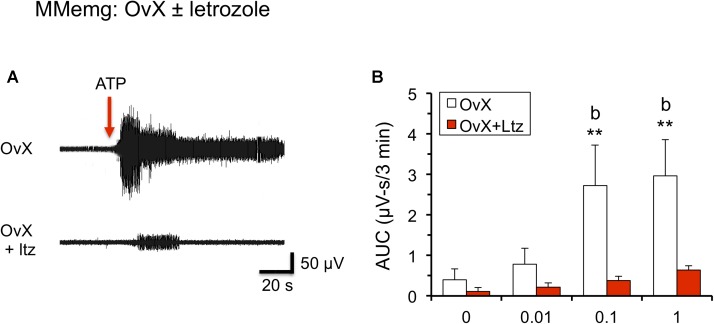
Systemic administration of letrozole (Ltz, 10 mg/kg, sc) for 4 days reduced ATP-evoked MMemg responses in OvX rats. (A) Example of MMemg activity evoked by intra-TMJ injection of ATP (1 mM, 20 μl) in OvX (upper panel) and OvX + Ltz rats (lower panel). (B) Summary of integrated MMemg activity evoked by ATP in OvX and OvX + Ltz rats. Arrow indicates the time of intra-TMJ ATP stimulation; ∗∗p < 0.01 versus vehicle, b = p < 0.01 versus OvX + letrozole (OvX + Ltz).